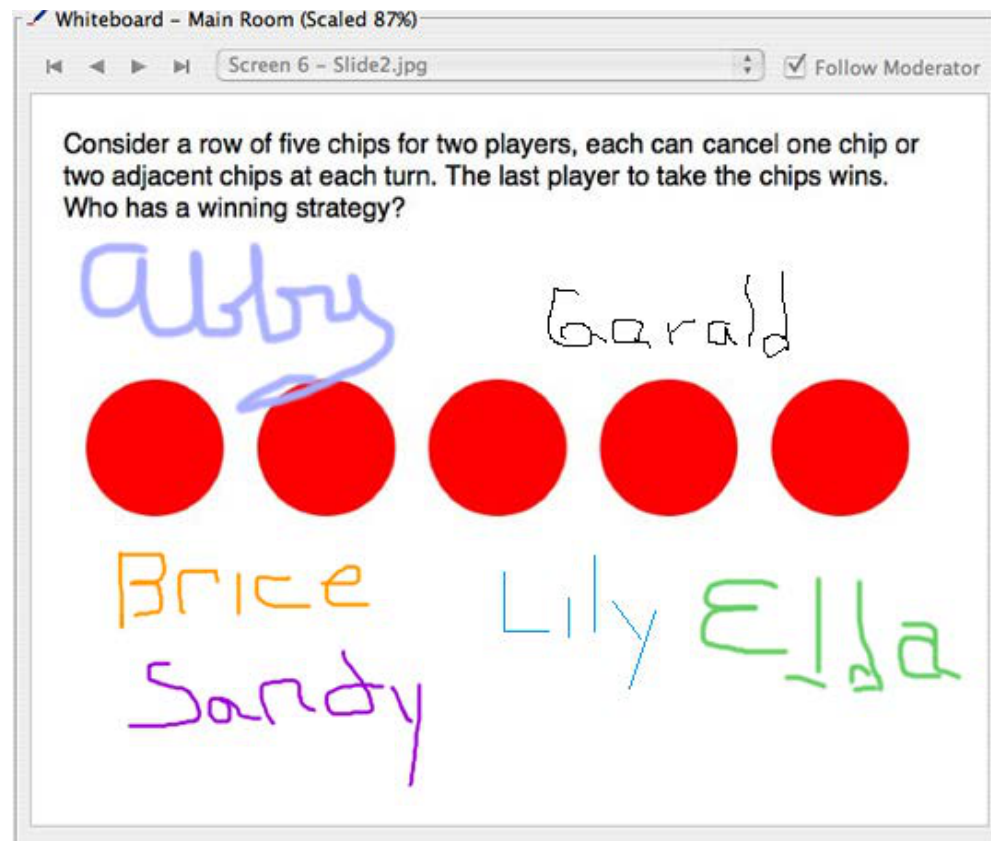
Figure 4 . Drawing coloured names to establish